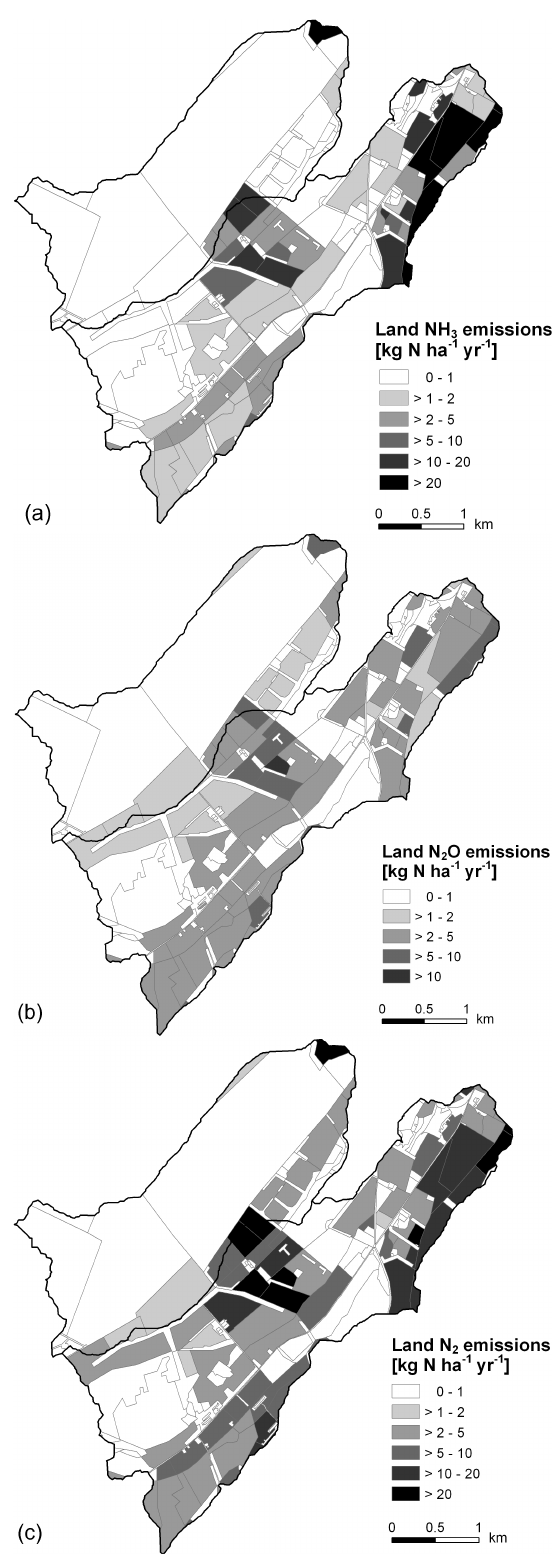
Fig. 5. Field-specific land surface emission maps of (a) NH 3 emis- sions, (b) direct N 2 O emissions, and (c) direct N 2